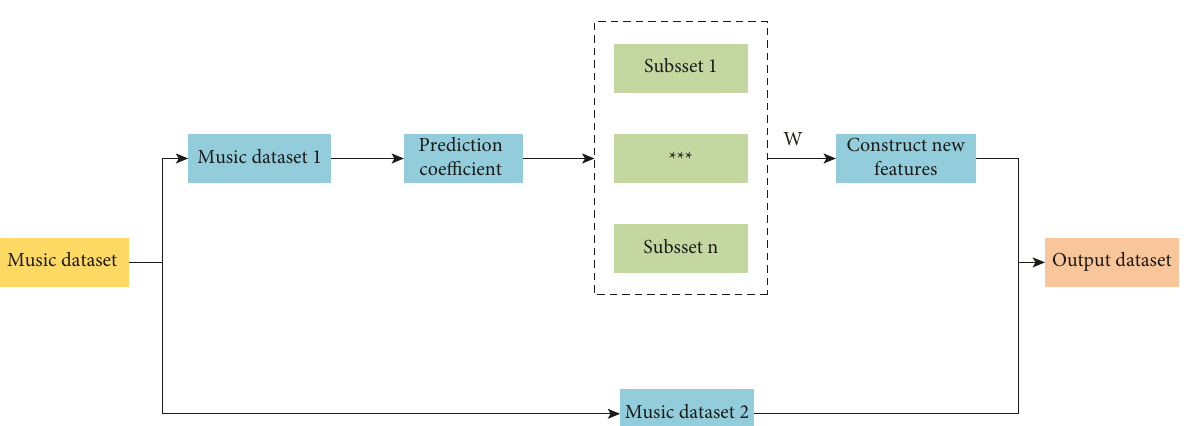
Figure 3: Prediction feature coefficients and the logistic regression algorithm processing the data steps diagram.